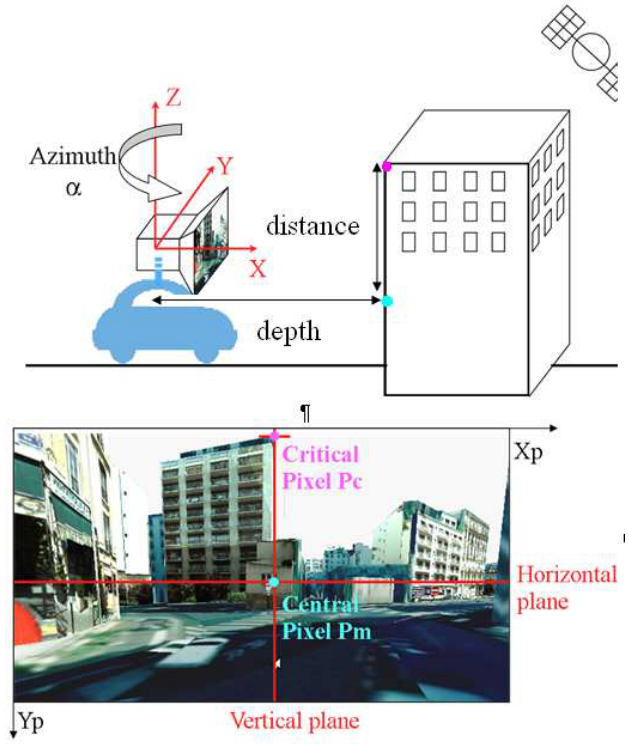
Figure 1. Illustration of the computation of the critical elevation using a virtual